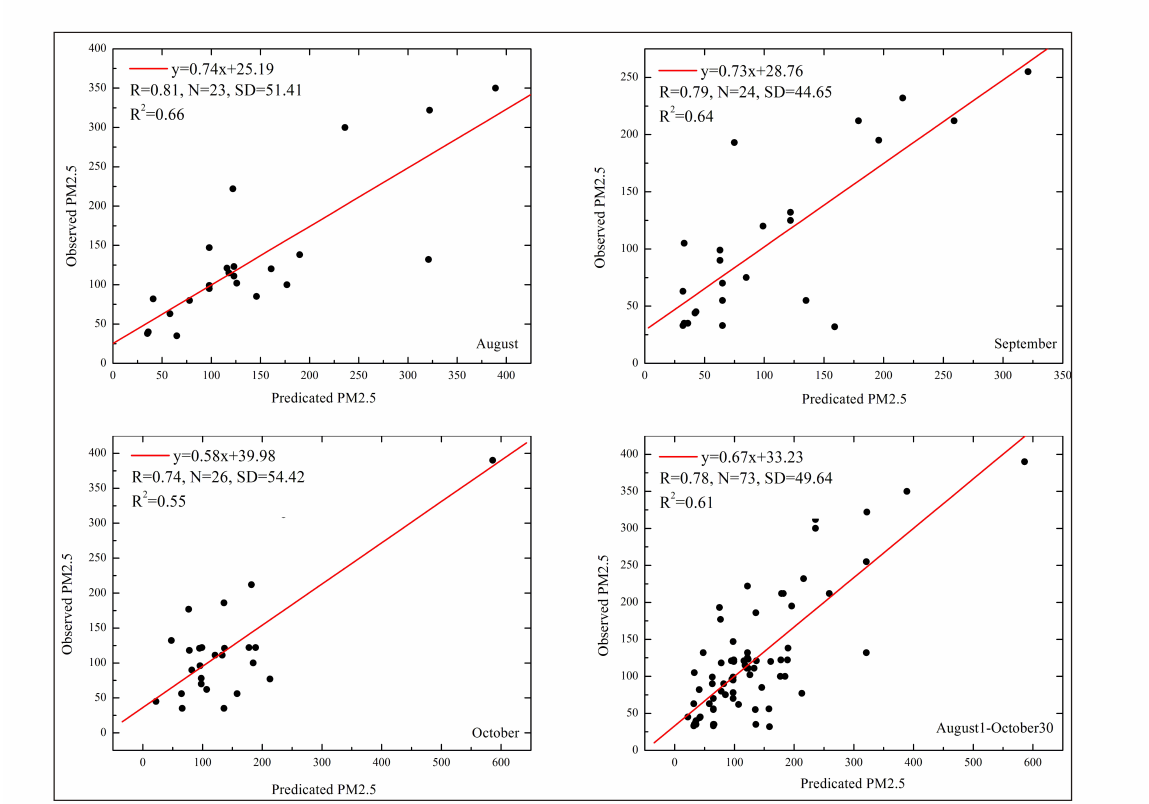
Figure 1. Scatter plots of Predicated PM2.5 vs. Observed